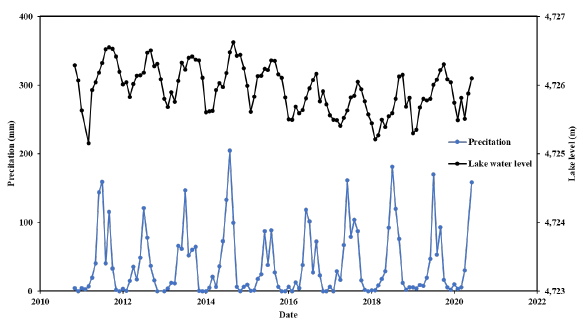
Figure 8 . Precipitation changes associated with the lake level tendency.